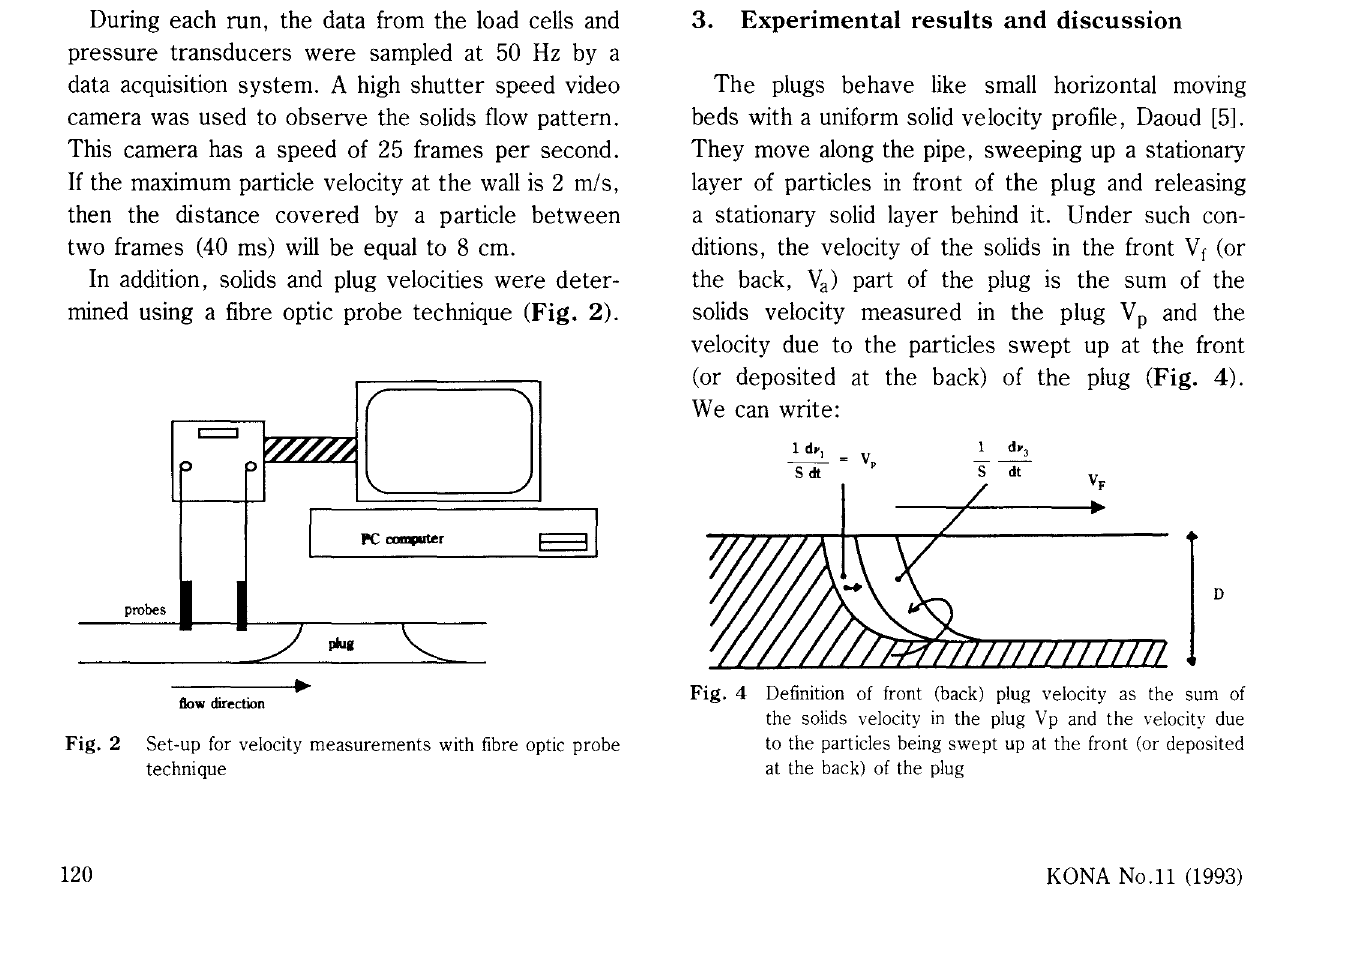
Fig. 4 Definition of front (back) plug velocity as the sum of the solids velocity in the plug V p and the velocity due to the particles being swept up at the front (or deposited at the back) of the plug